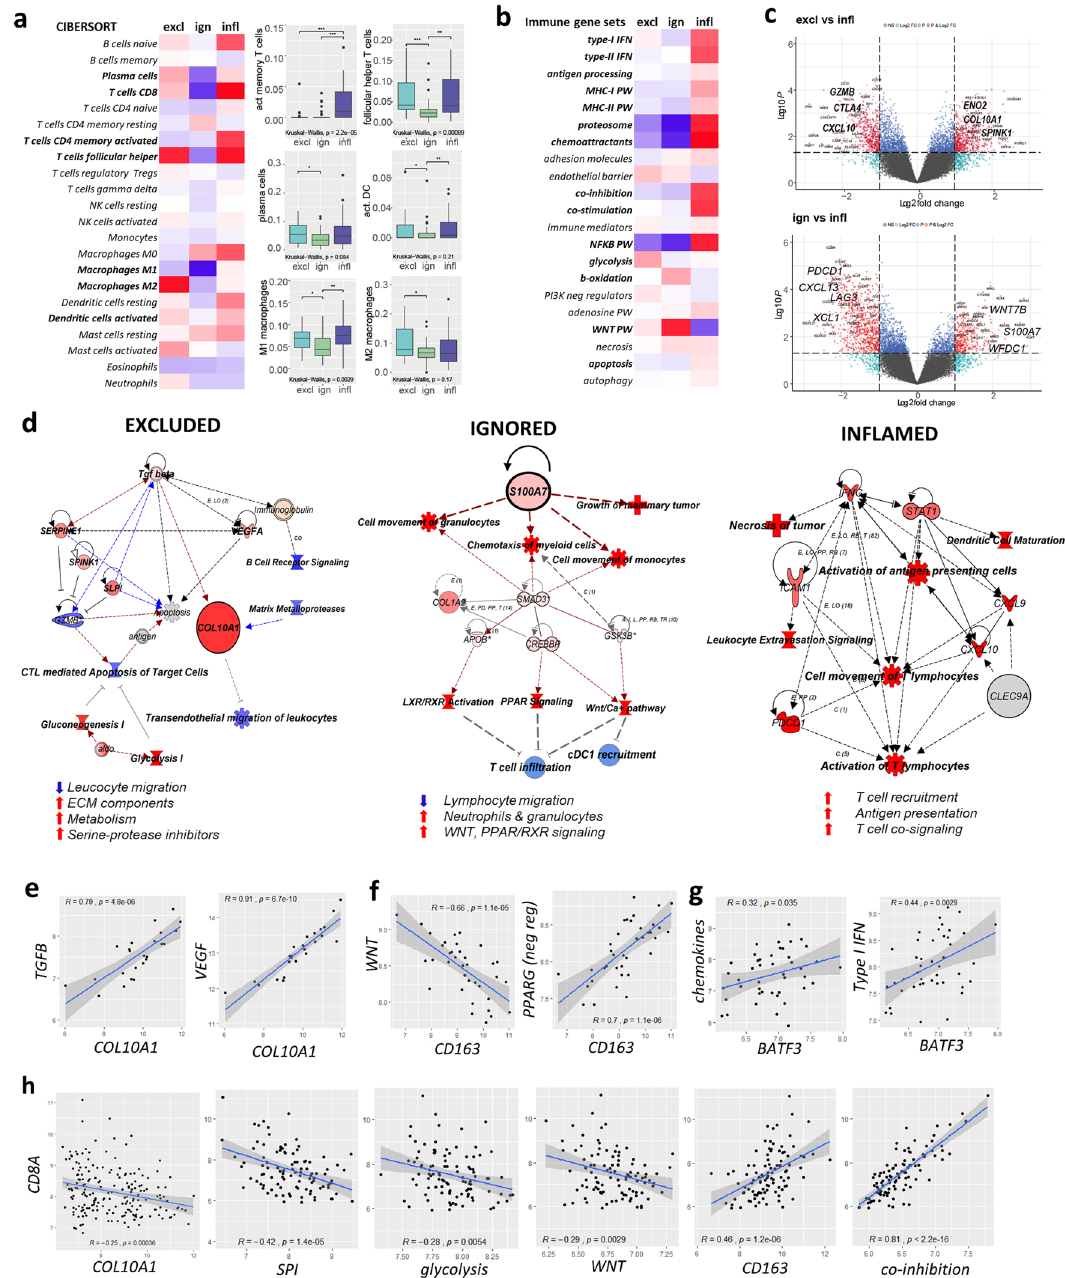
Fig. 4 Spatial phenotypes interrogated for immune determinants and evasive pathways. a Heatmap showing scaled average frequencies of immune cells based on Cibersort deconvolution (red: high, blue: low, immune cell subsets with signi fi cant differences among spatial phenotypes are indicated in bold); corresponding boxplots show median with 25th – 75th percentile and range (outliers are displayed as dots) of immune cell subsets with differential abundances among spatial phenotypes ( n = 101 LNN TNBC, of which n = 24 excluded, n = 33 ignored, and n = 44 in fl amed). b Heatmap showing scaled average expression of gene-sets related to T cell evasion (differential gene-sets are indicated in bold). c Volcano plot of differential gene expressions between excluded and in fl amed (upper), and ignored and in fl amed phenotypes (lower); top DE genes related to T cell evasion are shown in bold. d IPA analyses of cells, molecules, and pathways associated with spatial phenotypes (red: upregulated, blue:downregulated); and lists of major characteristics per spatial phenotype (bottom). e Correlations between expressions of COL10A1 and TGFB - or VEGF -signaling in the excluded phenotype. f Correlations between expressions of CD163 and WNT targets or negative regulators of PPAR genes in the ignored phenotype. g Correlations between the presence of activated dendritic cells (according to BATF3 expression) and expressions of chemokines or type-I IFN genes in the in fl amed phenotype. h Correlations between expressions of CD8A and various T cell evasive genes/gene-sets (all phenotypes) (all correlations show regression coe fi icients and p values). Signi fi cant differences are: *** p < 0.001; ** p < 0.01; * p < 0.05, NS, p > 0.05 (Kruskal – Wallis, one-sided). Source data are provided as the source data fi le.